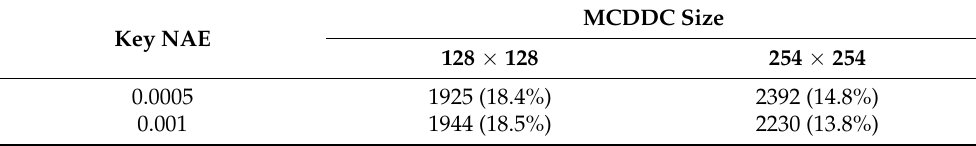
Table 2. Numbers of incorrectly decrypted pixels and error